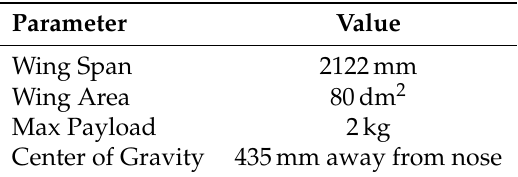
Table 6. Skywalker